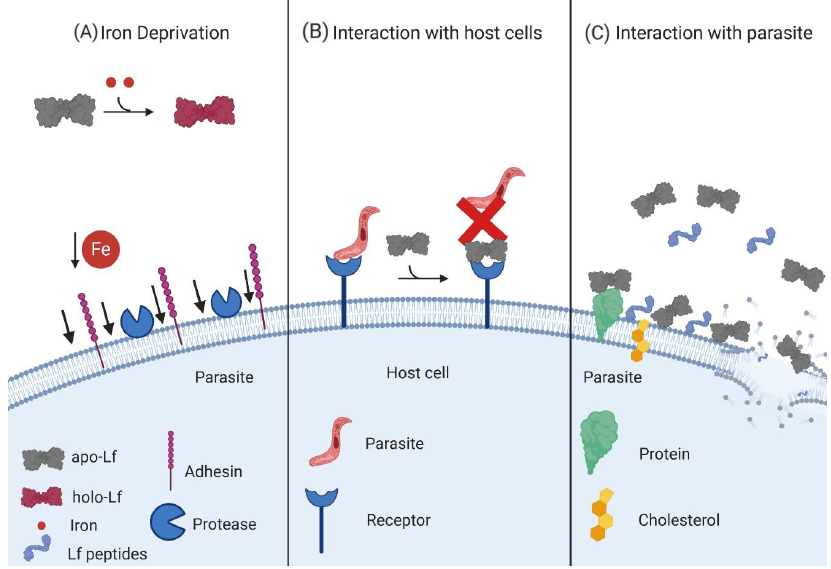
Figure 3. Mechanisms of the antiparasitic activity of lactoferrin (Lf) and lactoferricins (Lfcins). ( A ) Iron deprivation: by iron chelation in the environment, Lf may indirectly modulate virulence factors